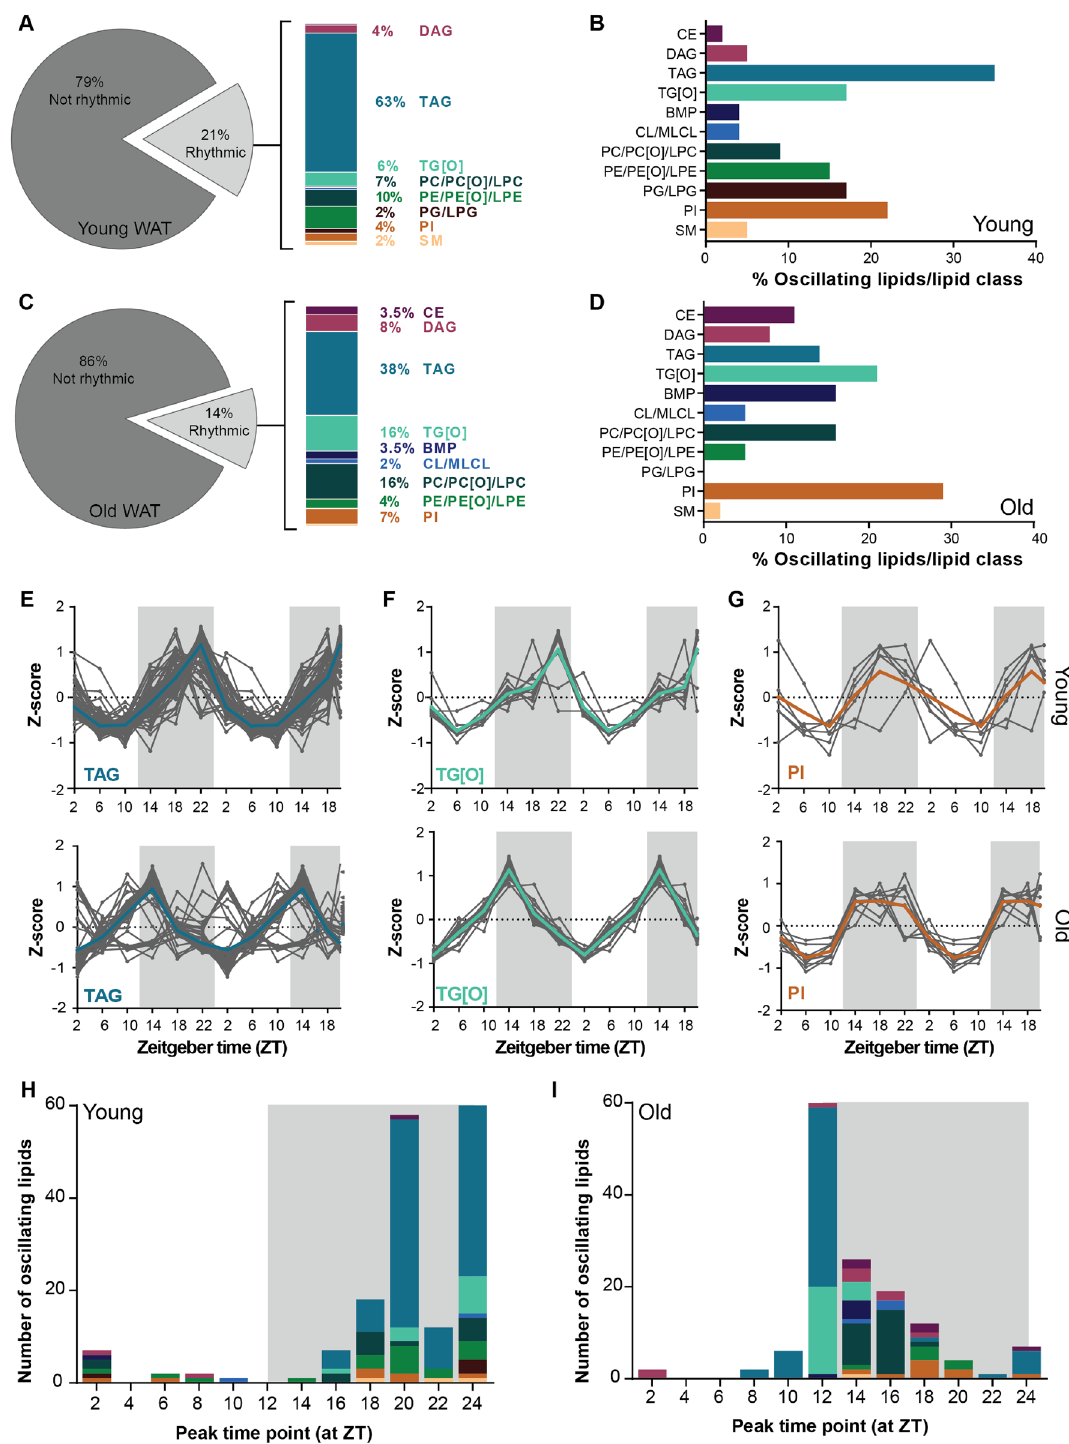
Figure 4. In WAT aging reduces number of rhythmic lipids and advances the lipid peak phase. ( A ) Percentage of rhythmic lipids in young and ( C ) aged mice as considered by JTK_CYCLE analysis. The rhythmic lipids were of different classes. Depiction of the rhythmic/lipid class percentage of young ( B ) and ( D ) aged mice. Double plotted rhythmic profiles of ( E ) TAGs, ( F ) TG[O]s and ( G ) PIs in young mice compared to aged mice. The gray lines represent the individual lipid species and the bold colored lines the group average. The data were double plotted to increase the visibility of day/night rhythms. The peak time point of individual lipids species depicted with the color to their corresponding lipid class of young ( H ) and ( I ) aged mice (n = 4 per time point). Graphs were created in Graphpad Prism (v8.3.0; https ://www.graph pad.com/scien tific -softw are/prism /). Figure layout was prepared in Adobe Illustrator CS6 (v16.0.3; https ://www.adobe